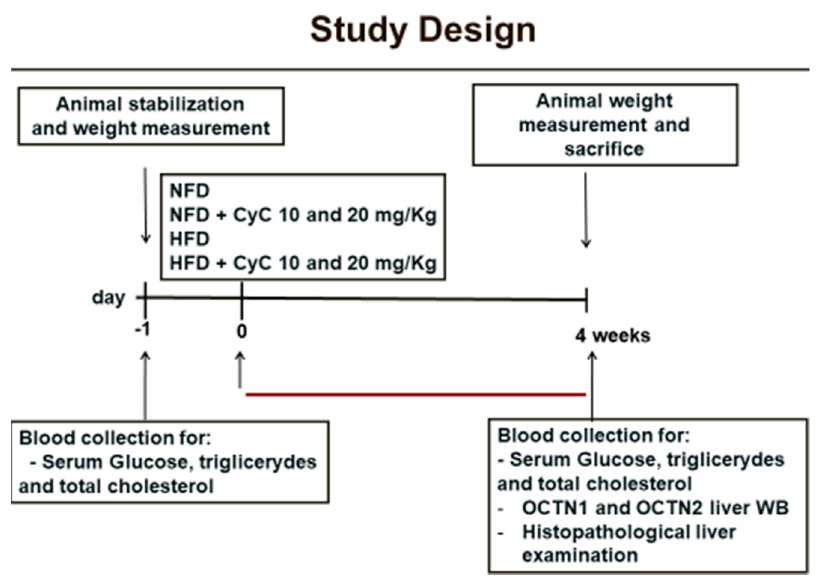
Figure 1. Study design.